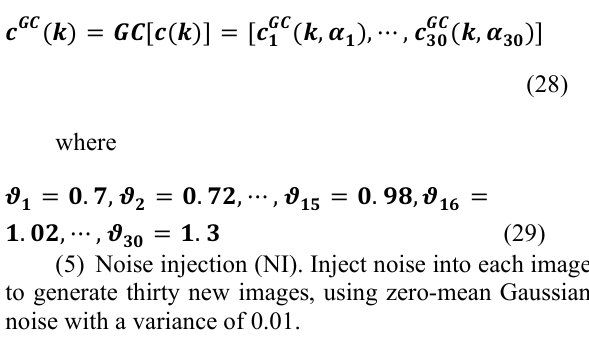
Table 5 Training dataset data augmentation